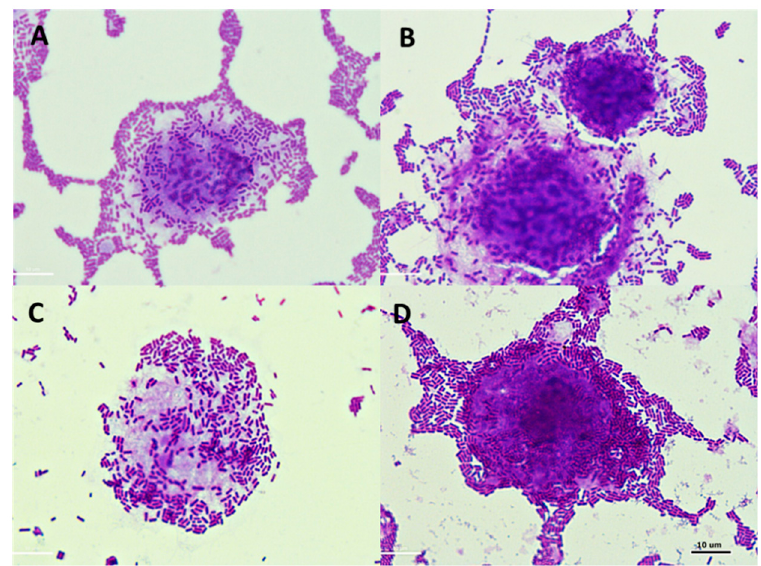
Figure 7. Microphotographs (magnification × 1000) showing adhesion of Lactobacillus sp. to Caco-2 cells in the presence of and without apple pomace hydrolysates: ( A ) Lb. plantarum 0991, ( B ) Lb. plantarum 0991 + preparation P1, ( C ) Lb. plantarum 0989, ( D ) Lb. plantarum 0989 + preparation P3.